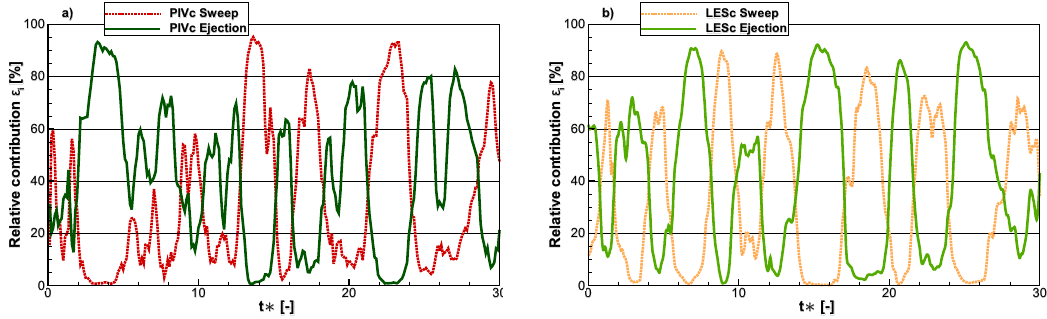
Figure 8. The segment with the time evolution of the sweep (red lines) and ejection (green line) relative contribution to the absolute total momentum flux for ( a ) PIVc and ( b ) LESc.